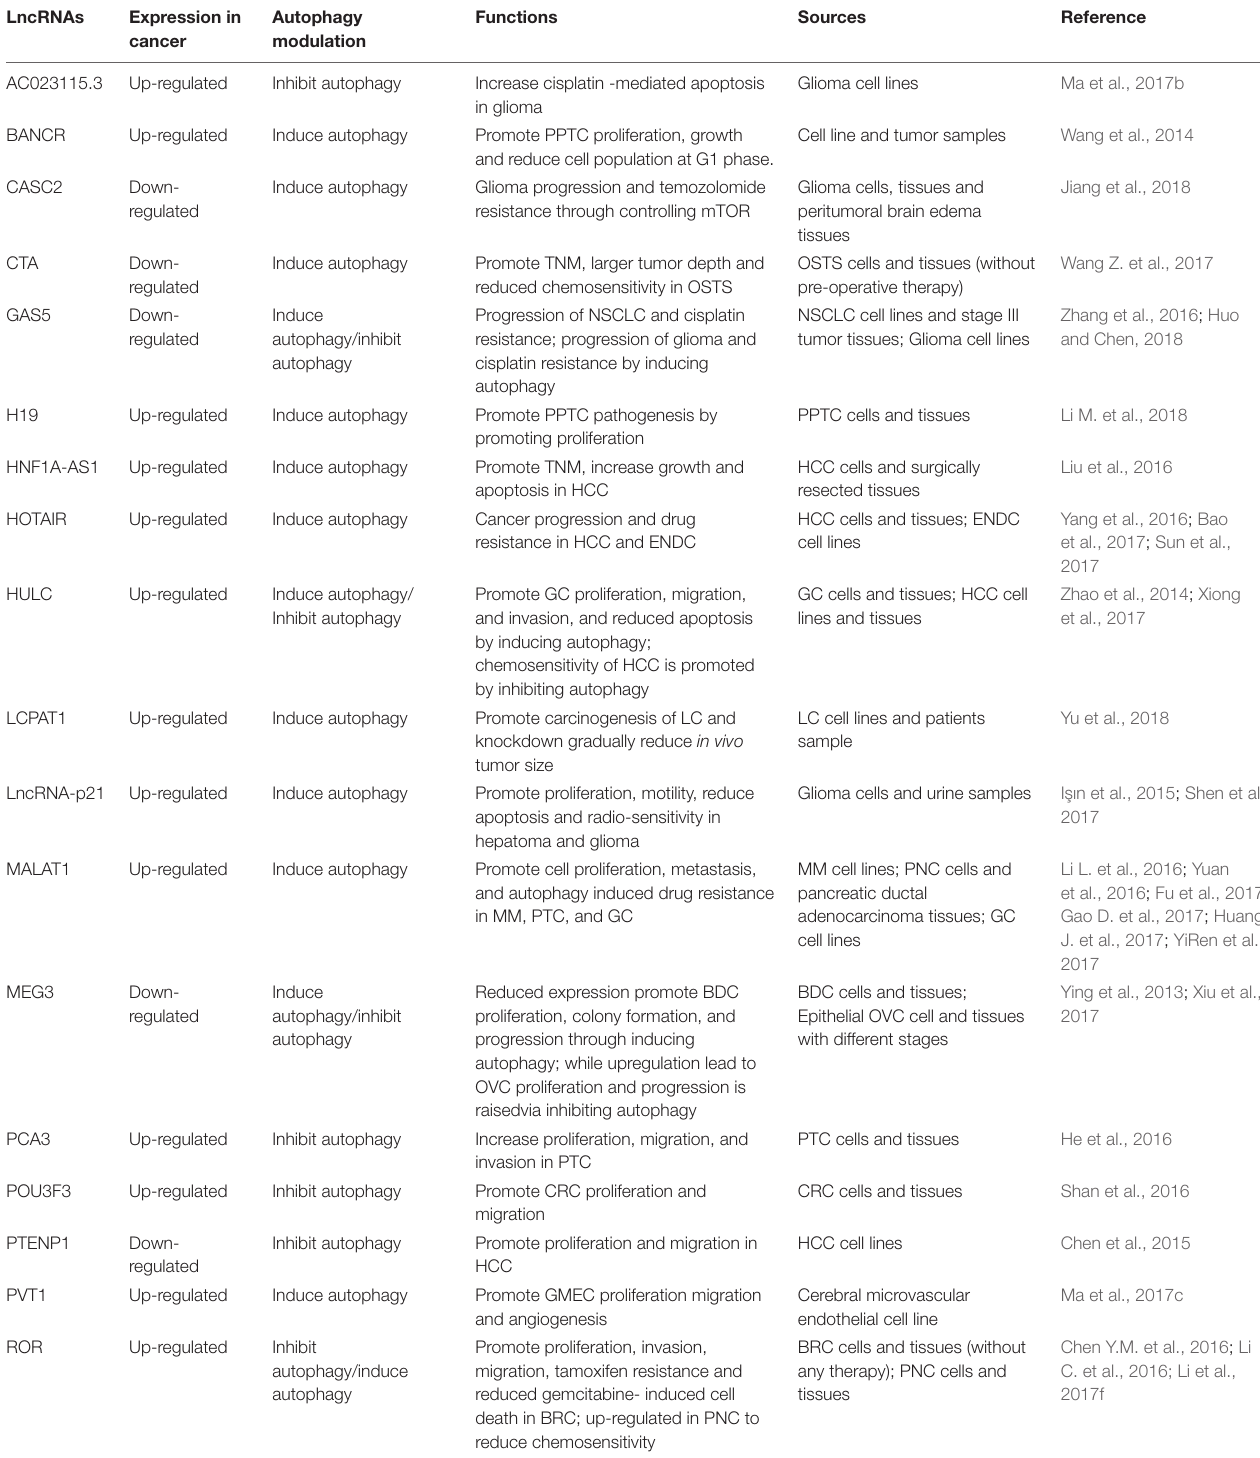
TABLE 1 | List of autophagy-modulating lncRNAs and their roles in various cancer.